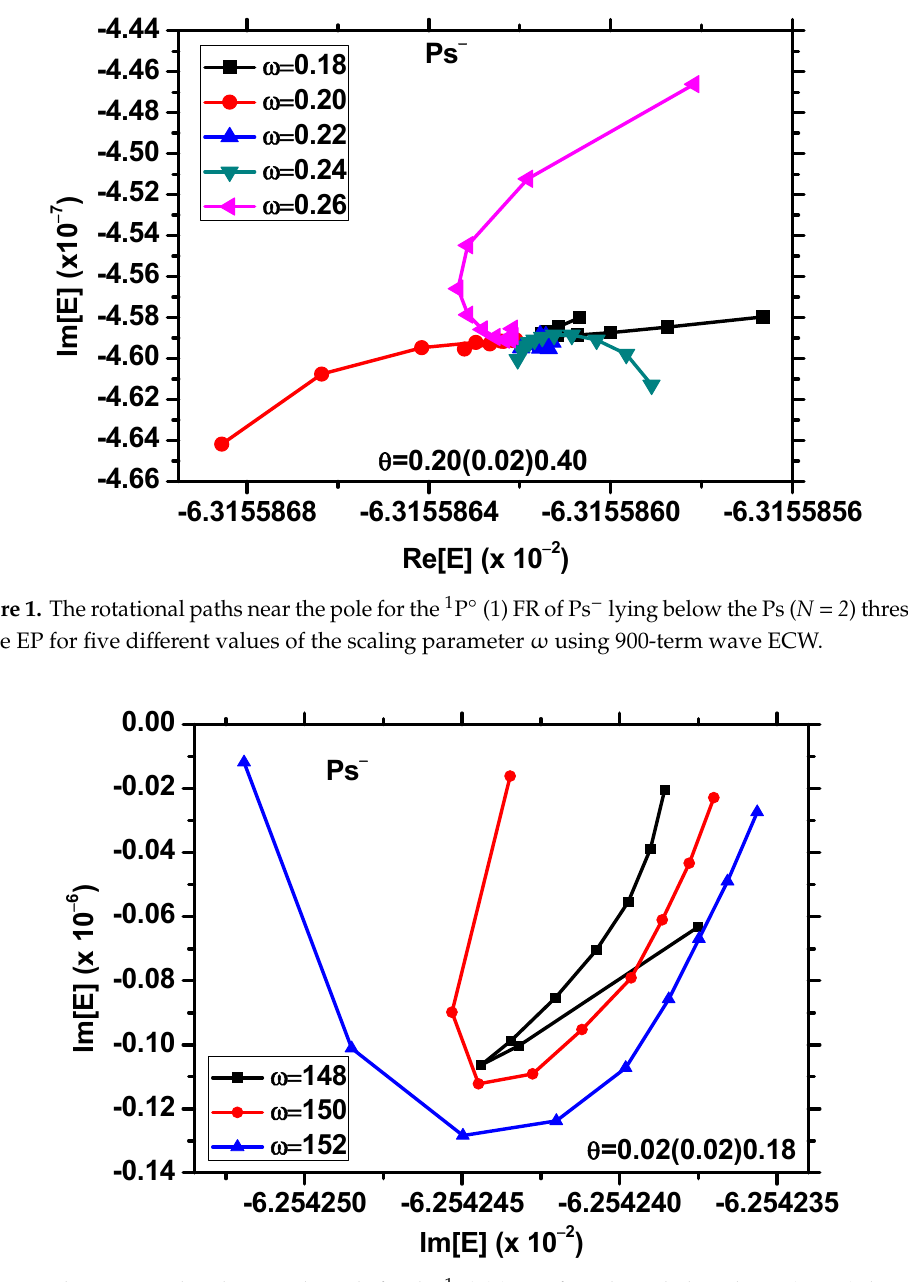
Figure 2. The rotational paths near the pole for the 1 P° (2) FR of Ps − lying below the Ps ( N = 2 ) threshold in the EP for three different values of the scaling parameter ω using 900-term ECW.